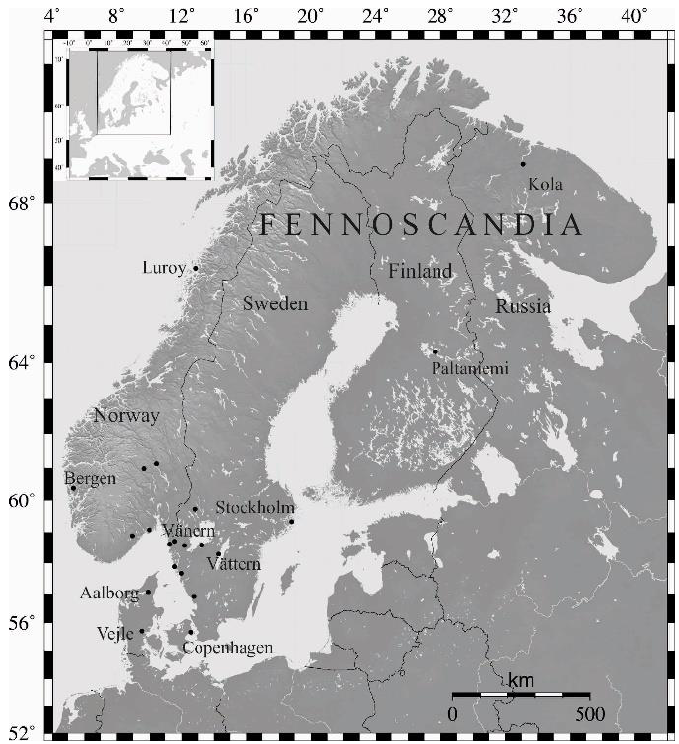
Figure 1. The target